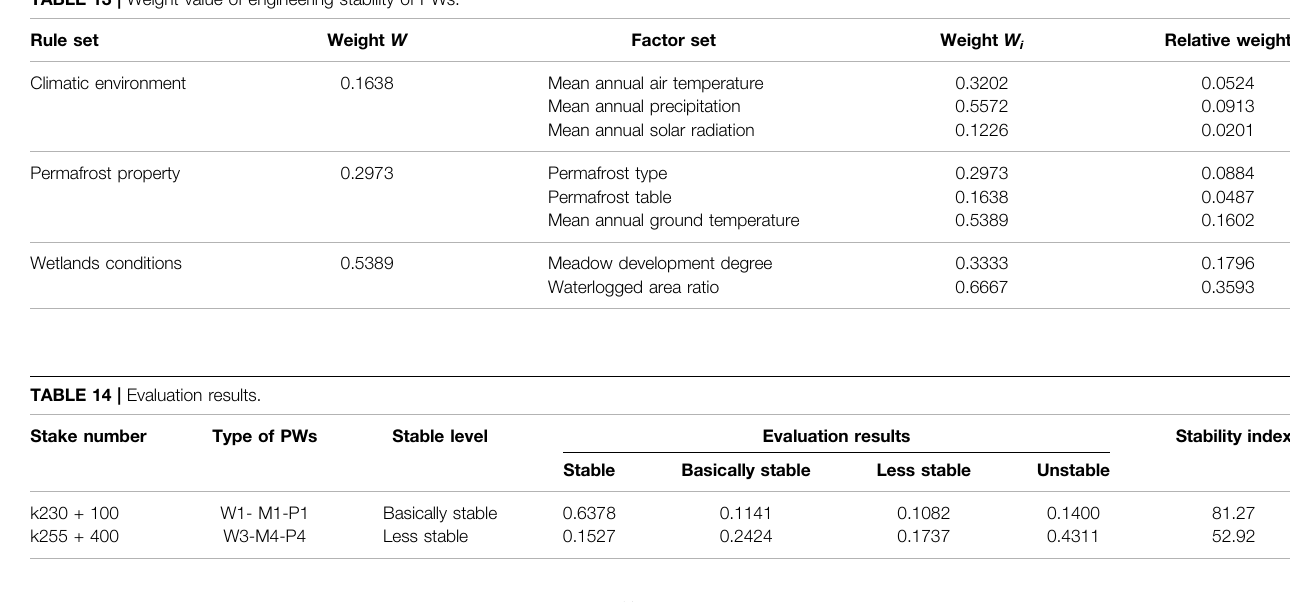
TABLE 13 | Weight value of engineering stability of